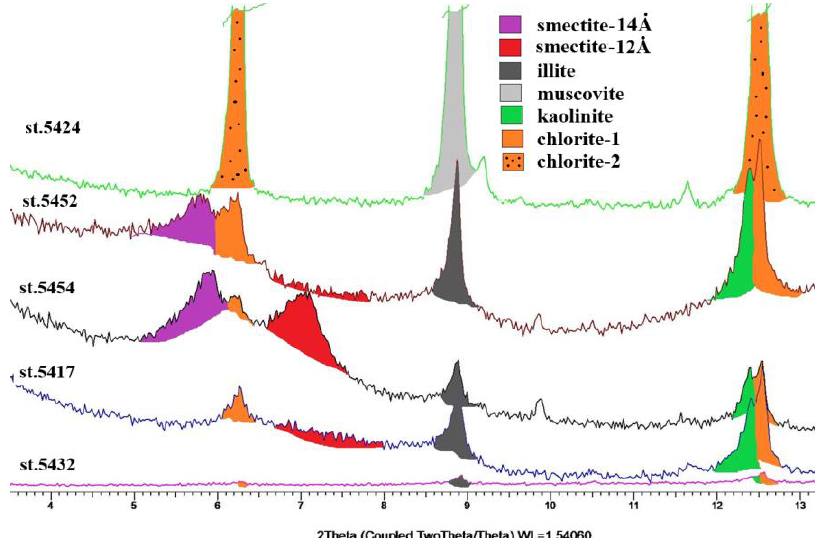
Figure 20. X-Ray difractograms' fragments (small-angle diffraction) of surface sediments (0–1 cm) from different areas of the Barents Sea: st. 5432—the Bear Island Through; st. 5417—the Central Deep, the Shtockman field; st. 5454—the Cambridge Strait, the Frans Josef Land Archipelago, st. 5452—the most northern core, Kola Transect; st. 5424—the Russkaya Gavan' Bay, the Novaya Zemlya Archipelago.